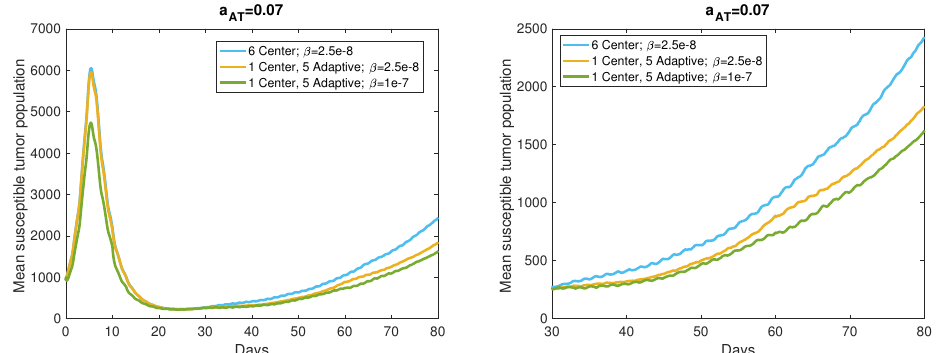
Figure 8. Means generated from 40 realizations for each parameter set, with antigenicity level a AT = 0.07. The blue curve is generated from simulations with six center viral doses and viral infection rate, β = 2.5 × 10 − 8 pfu − 1 h − 1 , the yellow curve is generated from simulations with one center dose and five adaptive doses and β = 2.5 × 10 − 8 , and the green curve is generated from simulations with one center dose and five adaptive doses and β = 1 × 10 − 7 .The graph on the right is a zoomed in version of the full trajectories on the left.